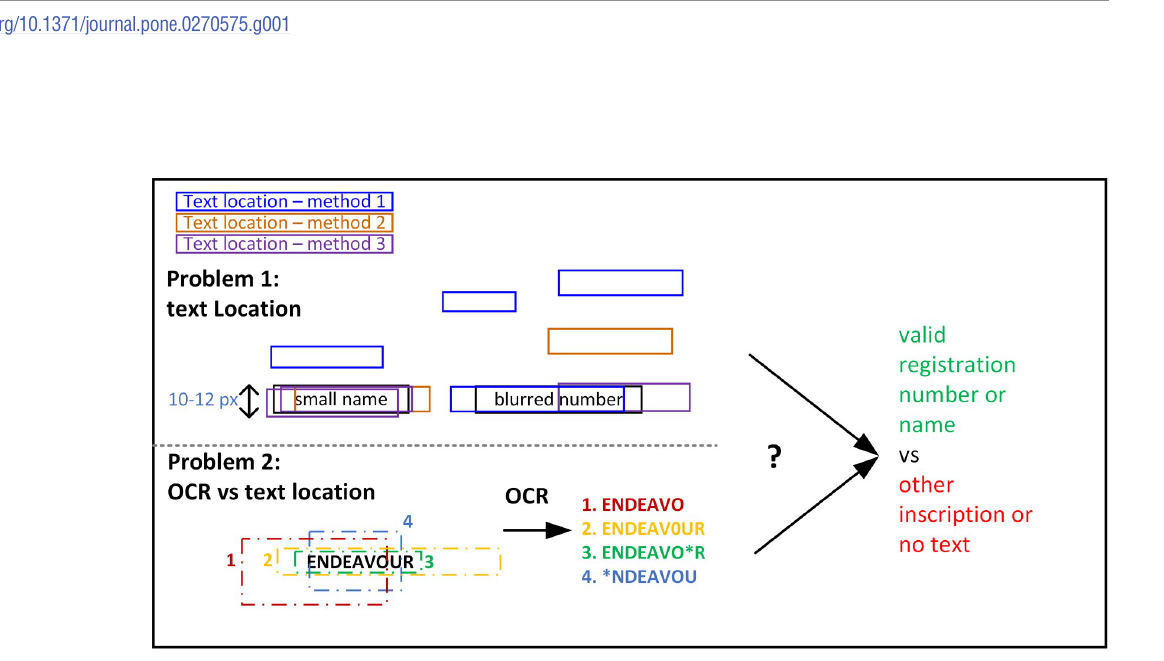
PLOS ONE | https://doi.org/10.1371/journal.pone.0270575 July 19,